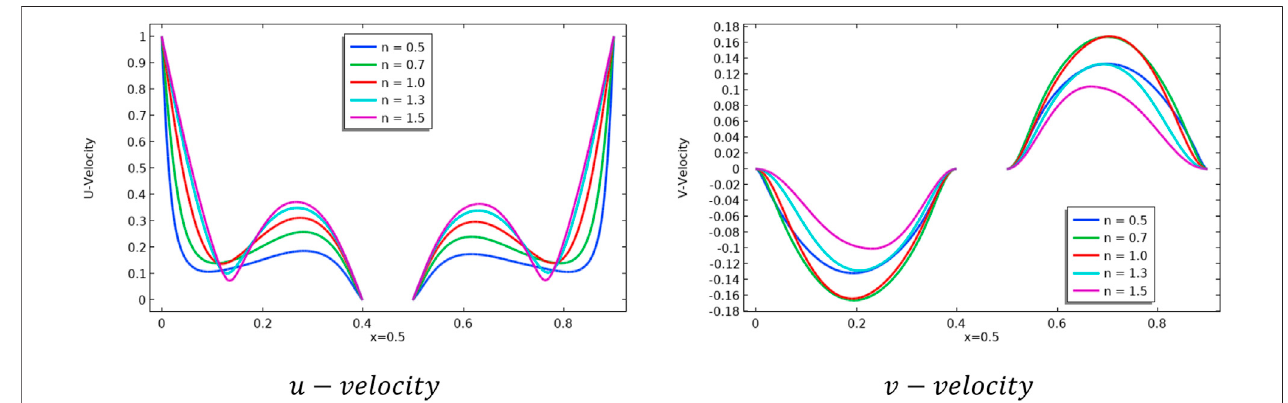
FIGURE 10 | Velocity line pro fi le against n at position x (cid:2) 0 . 5.